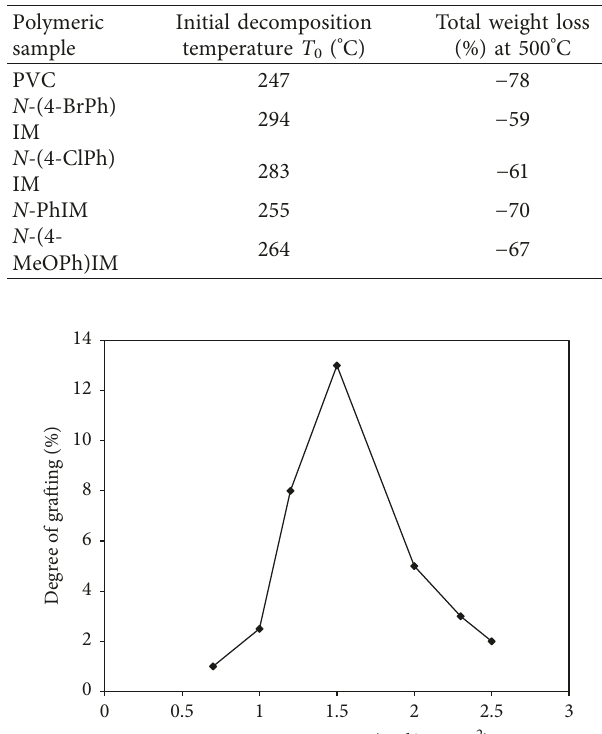
Table 2: Effect of thermal degradation at 180 ° C, in air, on the discoloration of the films of PVC modified by N -(4-BrPh)IM as compared to that of PVC.